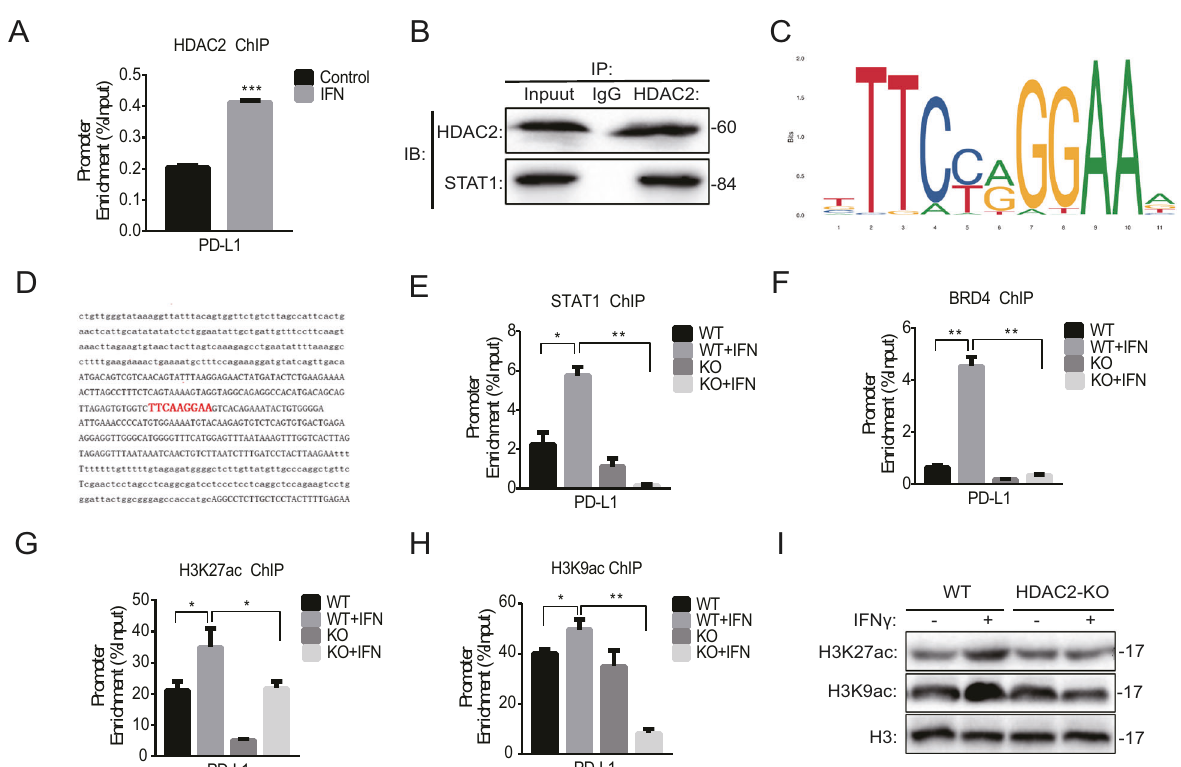
Fig. 4 HDAC2 knockout decreased IFN γ -induced STAT1 recruitment and histone acetylation of PD-L1 promoter. A ChIP-qPCR was performed after 4T-1 cells (WT, HDAC2-KO) were treated with or without IFN γ (100 U/ml) for six hours ( n = 3). B 4T-1 (WT, HDAC2-KO) cells were cultured with IFN γ (100 U/ml) for 24 h, and western blotting was performed after cells were precipitated with antibodies of HDAC2 or IgG. C , D The sequence ( C ) and position ( D ) of the binding sites of STAT1 in PD-L1 promoter. E – H ChIP-qPCR was performed using STAT1 ( E ), BRD4 ( F ), H3K27ac ( G ), and H3K9ac ( H ) antibodies after 4T-1 cells (WT, HDAC2-KO) were treated with or without IFN γ (100 U/ml) for six hours ( n = 3). I Western blotting was conducted after 4T-1 (WT, HDAC2-KO) cells were stimulated with or without IFN γ (100 U/ml) for 12 above mouse models and detected some molecular markers of T lymphocytes by fl ow cytometry technique. As shown in Fig. 6, compared to tumor from WT group, the HDAC2-KO group had a higher percentage of CD45 + lymphocytes, CD3 + , and CD8 + T cells, but not CD4 + population or CD4 + FOXP3 + Treg cells.